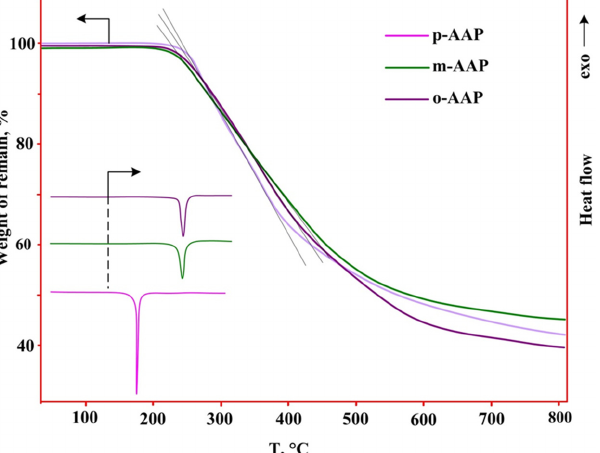
Polymers 2022 , 14 , x FOR PEER REVIEW Figure 3. TGA and DSC curves AAP (arrows show which scale corresponds to which thermograms).